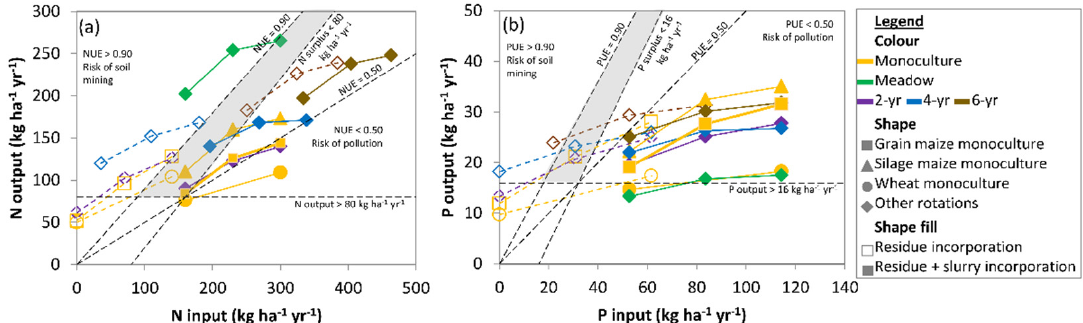
Figure 5. Graphical presentation of the nitrogen ( a ) and phosphorus ( b ) use efficiency (UE) in the long-term experiment. Observations are clustered according to crop rotation using colour (monoculture, meadow, 2, 4, and 6 yr), type of harvested product using shape (e.g., grain or silage maize), and residue management using fill (residue incorporation and residue + slurry incorporation). The lines corresponding to nutrient UE = 0.90, desired maximum surplus, UE = 0.50, and desired minimum productivity create the “sustainability area” (in light grey).